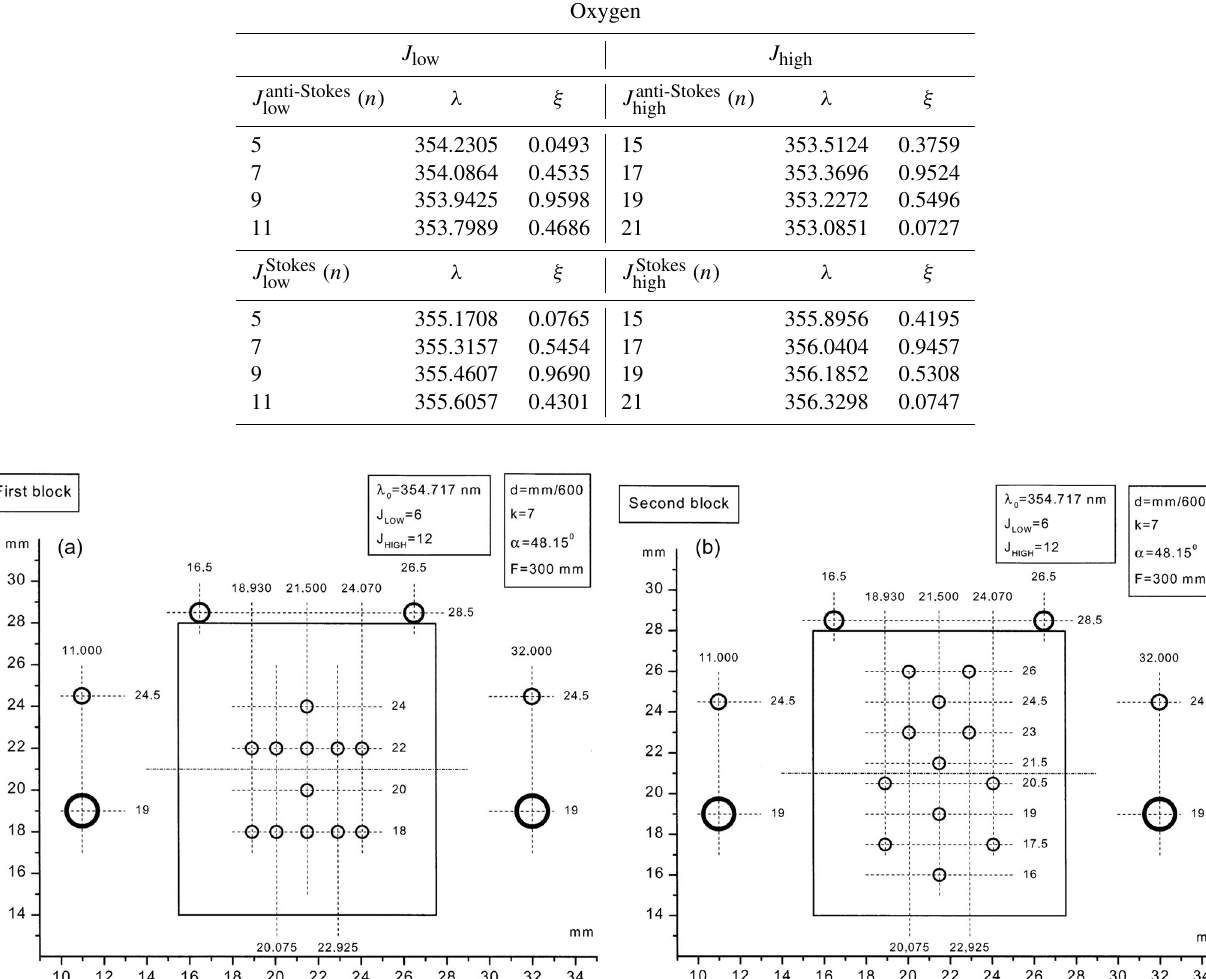
Figure 6. The outline of the two fibres’ blocks shows the positions of the input, output and intermediate (from stage 1 to stage 2) fibres as a function of the abscissa–ordinate, x – y Cartesian coordinates. (a) Two optic fibres transmitting the PRR and the elastic signals enter the temperature polychromator through the first fibre’s block. (b) The eight Stokes and anti-Stokes J signals are transmitted through the intermediate fibres into the second fibre’s block. The eight J signals are recombined by the diffraction grating polychromator into two groups of total J signals ( J high and J low ) and sent to the output fibres. Holes shown outside the fibre’s block are not fibre